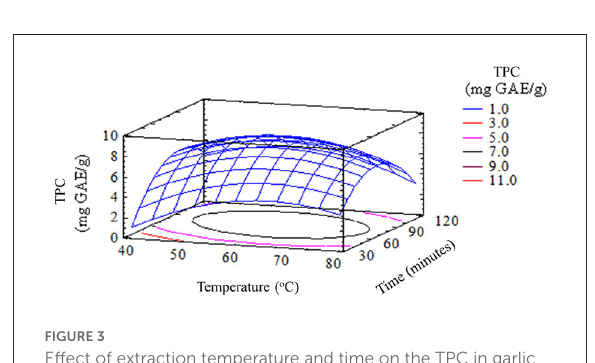
FIGURE3 Effect of extraction temperature and time on the TPC in garlic husk.